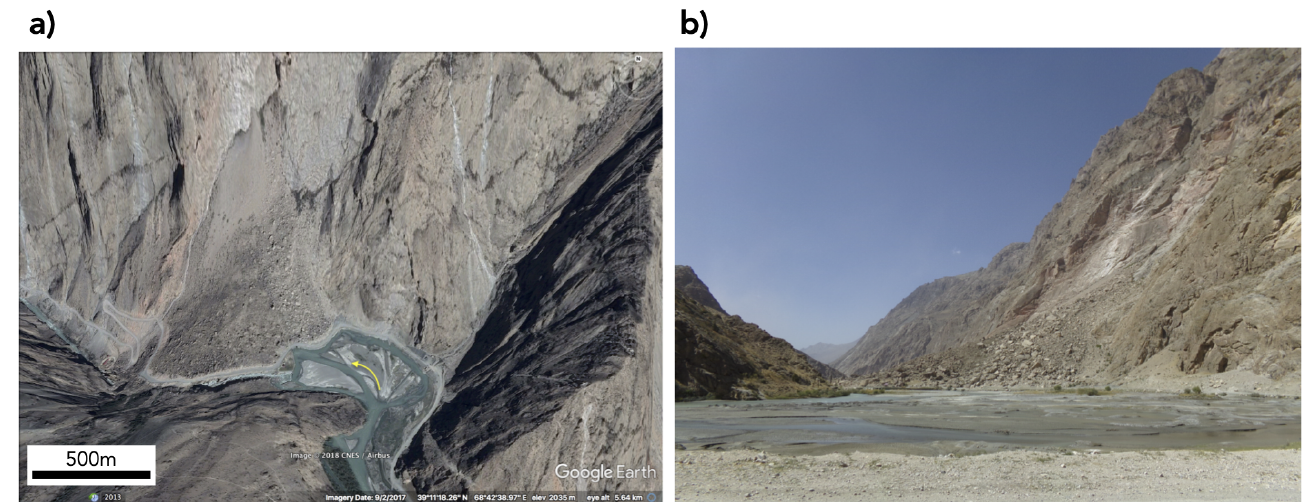
Figure 3. Yagnob river. ( a ) Google Earth view of a rockslide in the Yagnob valley. The valley morphology changes from flat-bottom upstream to V-shaped downstream. ( b ) Close view of the area upstream of the rockfall (background) with the anastomosing river and remnants of lake deposits